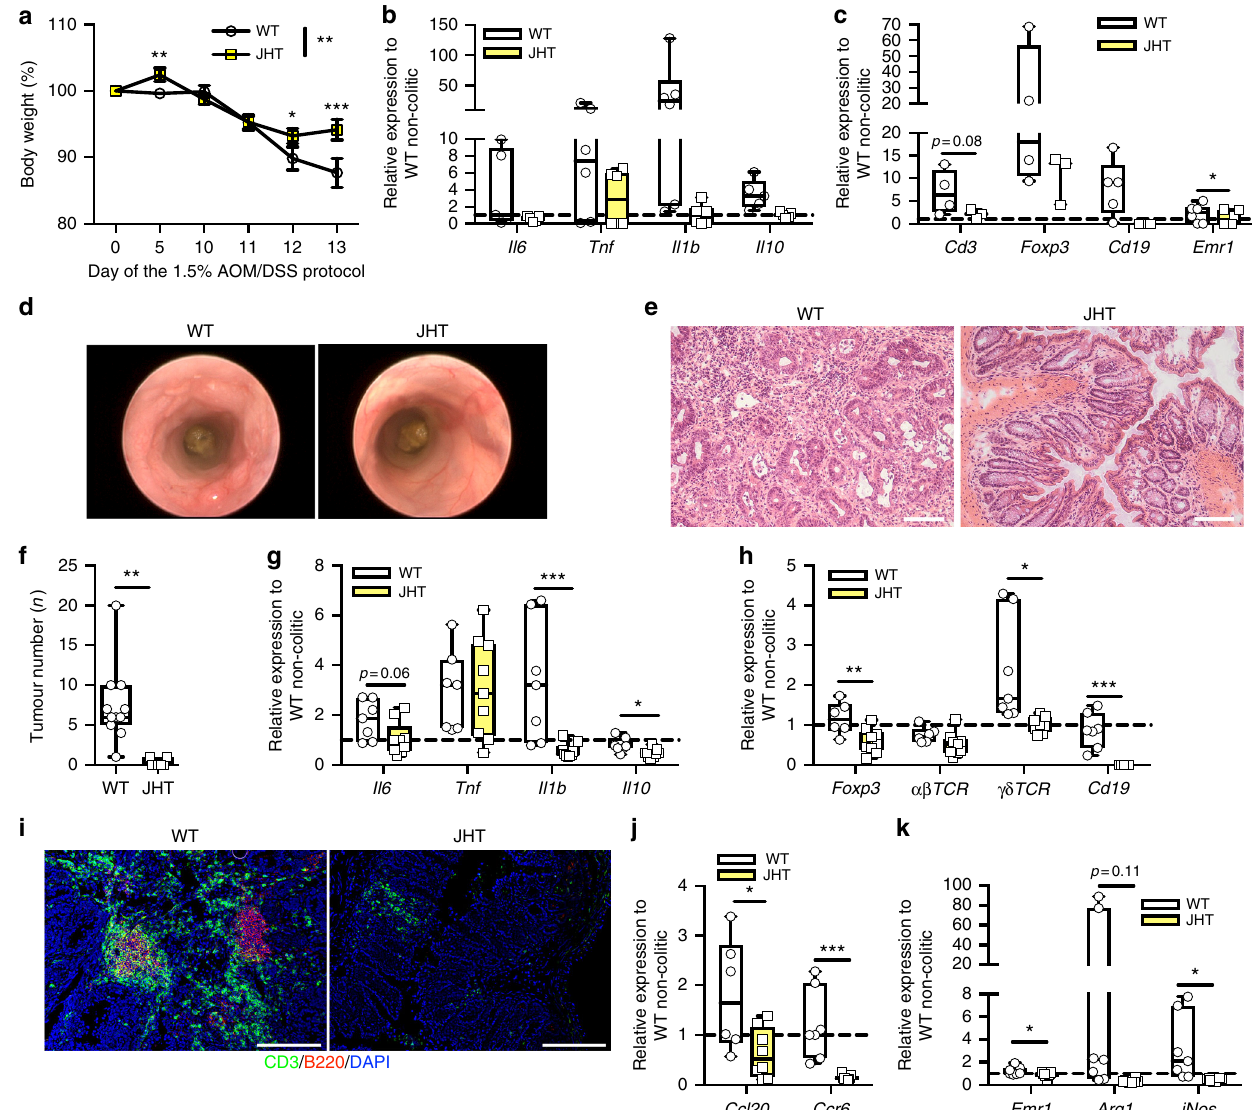
Fig. 6 Recruitment of CCR-6-expressing B cells alters the TME to promote CAC. a Body weight loss in % of NCD-fed WT ( n = 17) and JHT ( n = 14) mice at day 0 to day 13 of the 1.5% AOM/DSS protocol. b , c qPCR analysis of indicated gene expression in colitic colons of 10-week-old NCD-fed WT and JHT ( n = 3 – 9) mice at day 13 of the 1.5% AOM/DSS protocol, results are presented relative to non-colitic WT colons at day 0. d Representative endoscopic pictures of 13-week-old NCD-fed WT and JHT mice of the 1.5% AOM/DSS protocol. e H&E staining of colons from NCD-fed 17-week-old WT and JHT mice at day 62 of the 1.5% AOM/DSS protocol. f Tumour number of 17-week-old NCD-fed WT ( n = 11) and JHT ( n = 7) mice counted at day 62 of the 1.5% AOM/DSS protocol. g , h qPCR analysis of indicated gene expression in colons of 17-week-old NCD-fed WT ( n = 7) and JHT ( n = 9) mice at day 62 of the 1.5% AOM/DSS protocol, results are presented relative to non-colitic WT colons at day 0. i Representative immuno fl uorescent stainings of CD3 (green)-expressing T cells and B220 (red)-expressing B cell in colons of 17-week-old NCD-fed WT and JHT mice at day 62 of the 1.5% AOM/DSS protocol. j , k qPCR analysis of indicated gene expression in colons of 17-week-old NCD-fed WT ( n = 7) and JHT ( n = 9) mice at day 62 of the 1.5% AOM/ DSS protocol, results are presented relative to non-colitic WT colons at day 0. AOM, azoxymethane; DSS, dextran sodium sulphate; NCD, normal chow diet; CAC, colitis-associated colorectal cancer; TME, tumour microenviroment; JHT, targeted deletion of the JH locus. Data are represented as mean + SEM or centre line: median; box limits: 1st and 3rd quartiles; whisker: maximum to minimum, * p ≤ 0.05, ** p ≤ 0.01 and *** p ≤ 0.001 two-tailed unpaired Student ’ s t -test f or two-way ANOVA followed by Fisher LSD a , b , c , g , h , j , k . Scale bar, 50 μ m e , 200 μ m